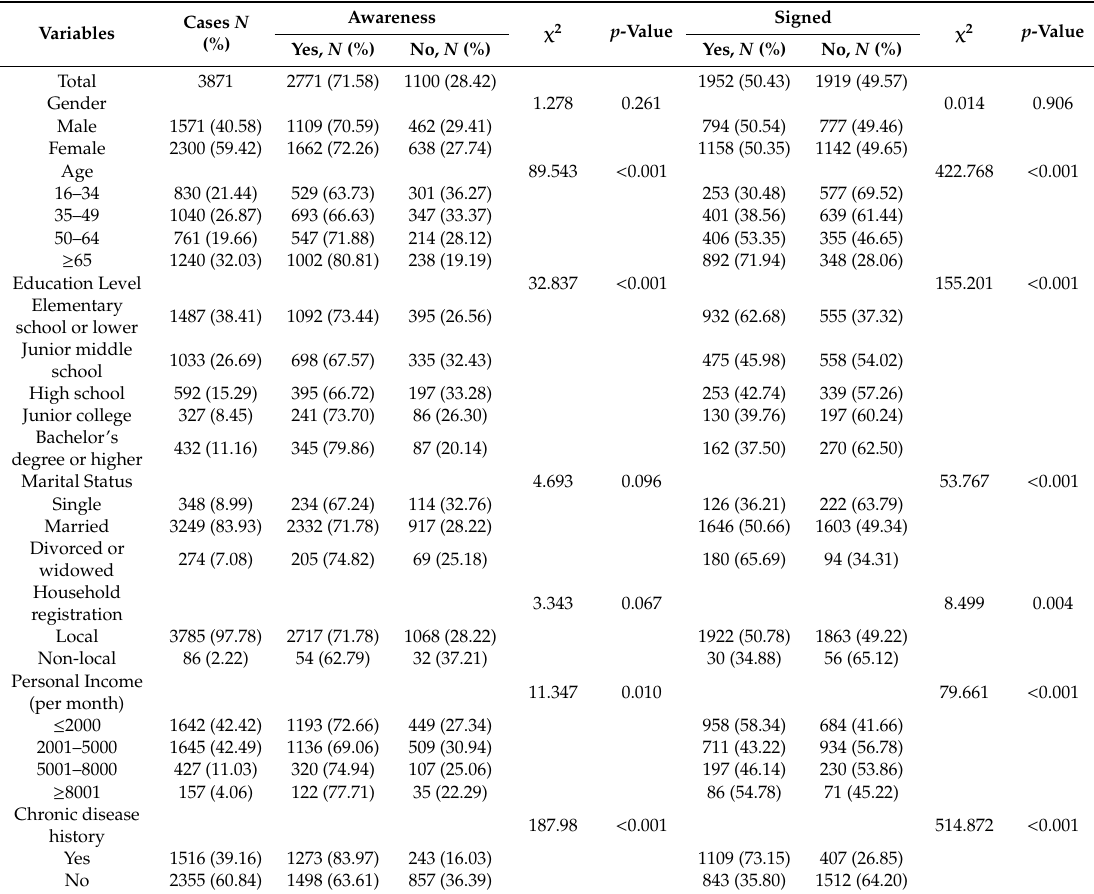
Table 1. Awareness of family doctor contract services (FDCS) and signing status among residents of Zhejiang